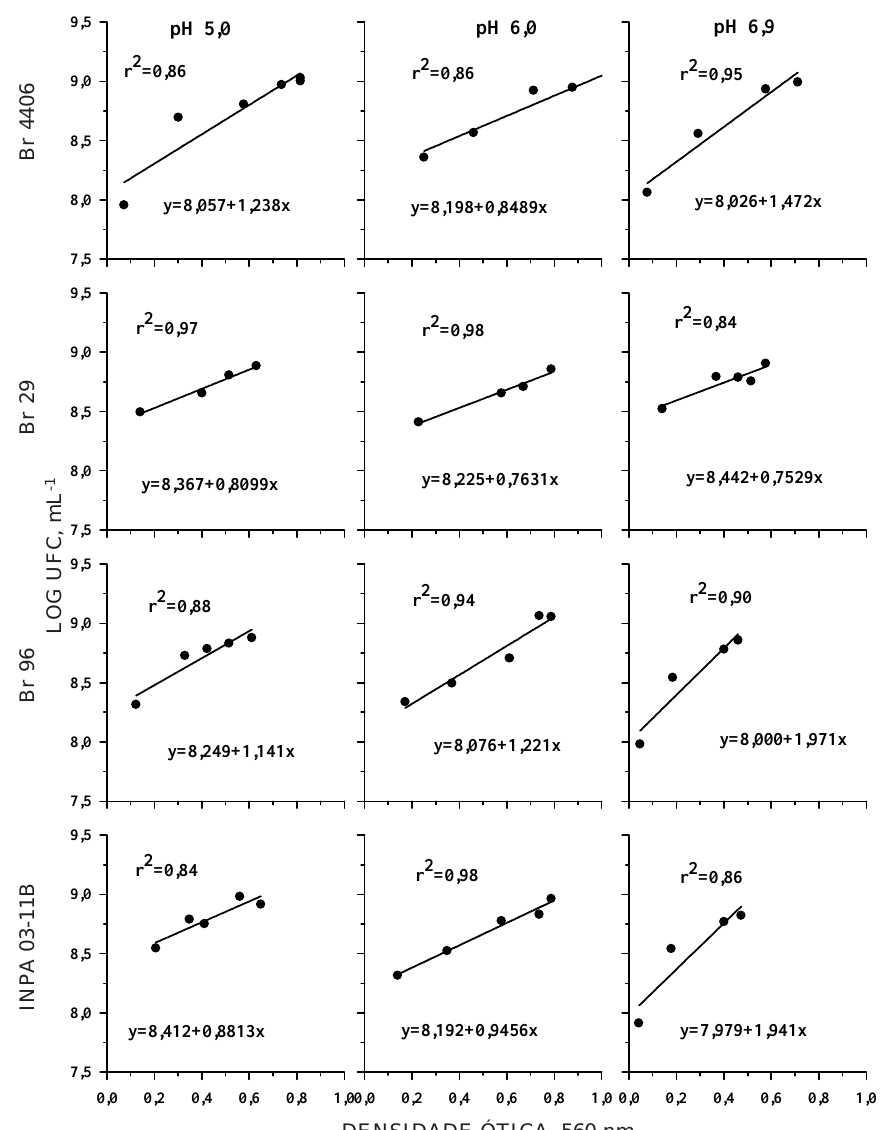
Figura 2. Relação entre o Log de UFC, considerando a densidade ótica das estirpes de Bradyrhizobium nos valores de pH 5,0; 6,0 e 6,9.